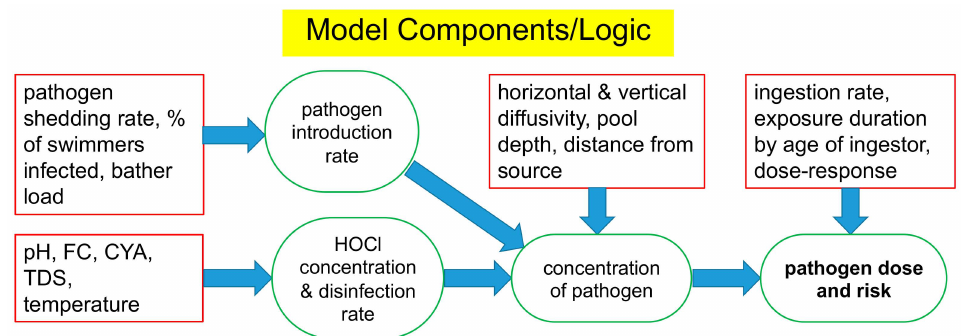
Figure 1. Input variables (rectangles) and calculated results (ovals) for each component of the steady-state turbulent di ff usion model of pathogen